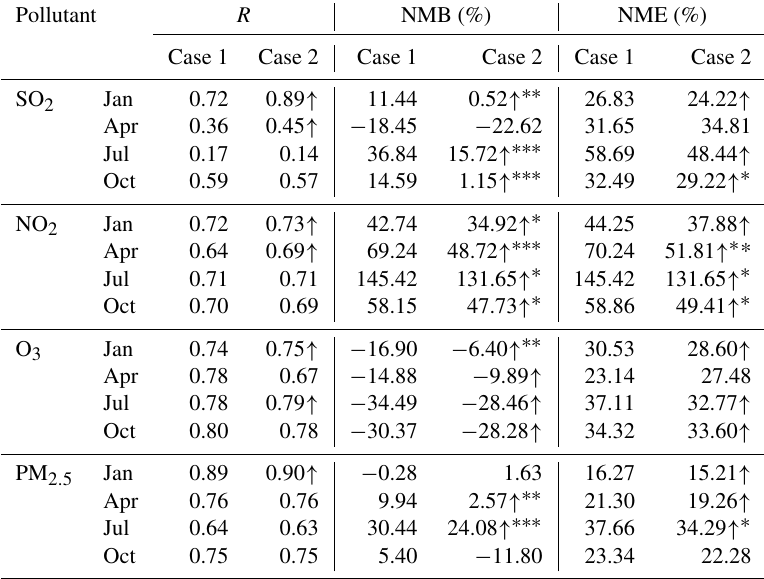
Table 2. Comparison of the observed and simulated hourly SO 2 , NO 2 , O 3 , and PM 2 . 5 concentrations by month for cases 1 and 2 in the YRD region. In total, 230 state-operated observation sites were included in the comparison.